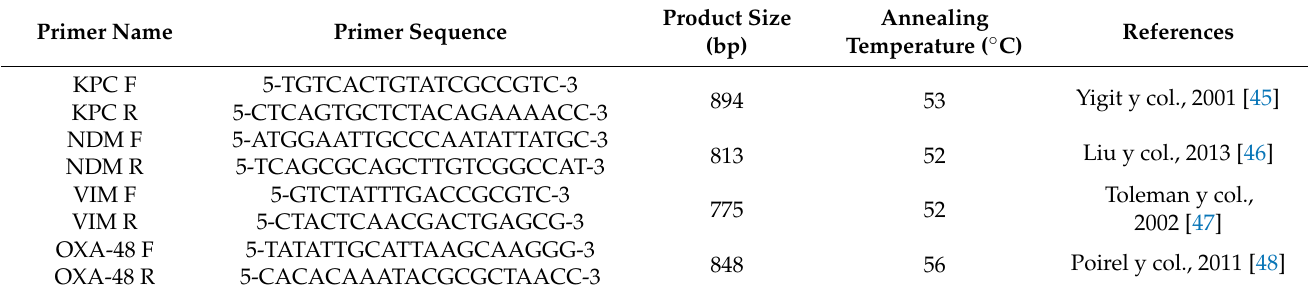
Table 4. Primers used for polymerase chain reaction of the carbapenem-resistant E. cloacae complex